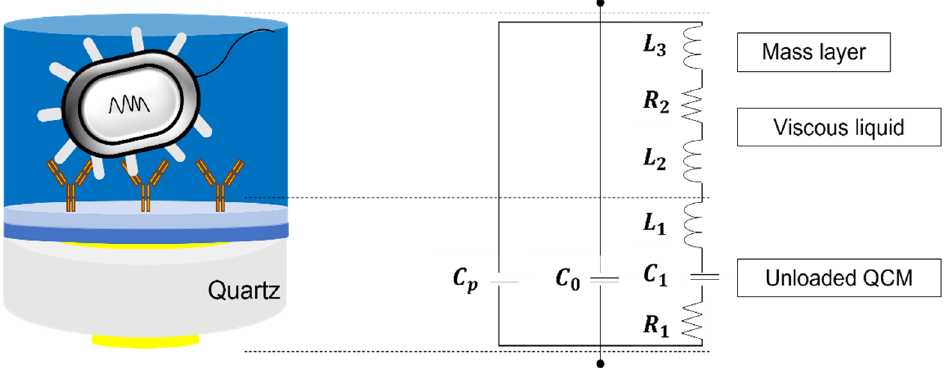
Figure 1. A quartz crystal in liquid media can be modeled as an electric circuit which is the Butter ‐ worth (cid:3398) Van Dyke equivalent circuit model. An unloaded QCM itself can be expressed by 𝑅 (cid:2869) , 𝐿 (cid:2869) , 𝐶 (cid:2869) , 𝐶 (cid:2868) and 𝐶 (cid:3043) . When it is in liquid media, the electric circuit is extended by adding additional 𝐿 (cid:2870) and 𝑅 (cid:2870) terms for the viscous liquid and 𝐿 (cid:2871) for the thin rigid